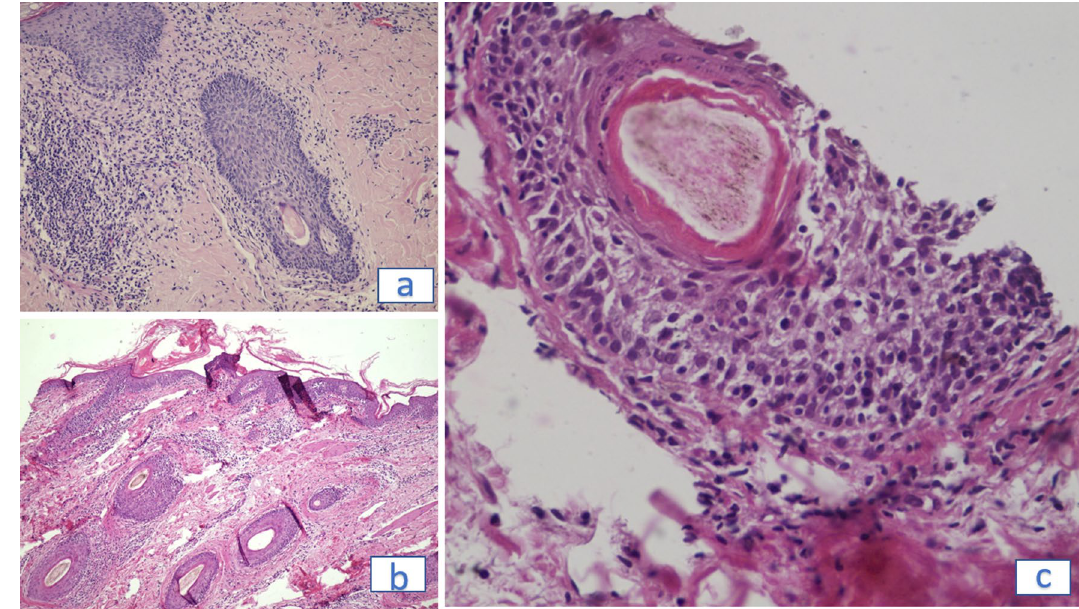
Figure 3. Scalp histopathology in erythrodermic CTCL. (a) Hair follicles with folliculotropism of atypical lymphocytes and uneven thickness of the outer root sheath (H&E, x200). (b) On the epidermal surface the prominent follicular keratotic spicule and interfollicular scale are visible in the scalp biopsy from the patient with erythrodermic mycosis fungoides. (H&E, × 100). (c) The fragment of a middle portion of the pili torti obtained in trichoscopy guided biopsy. The oval smooth shape of the hair shaft is lost. The hair epithelium is changed by lymphocytic inflammation, which leads to irregular thickness of the outer root sheath and the subsequent hair twisting. (H&E, ×